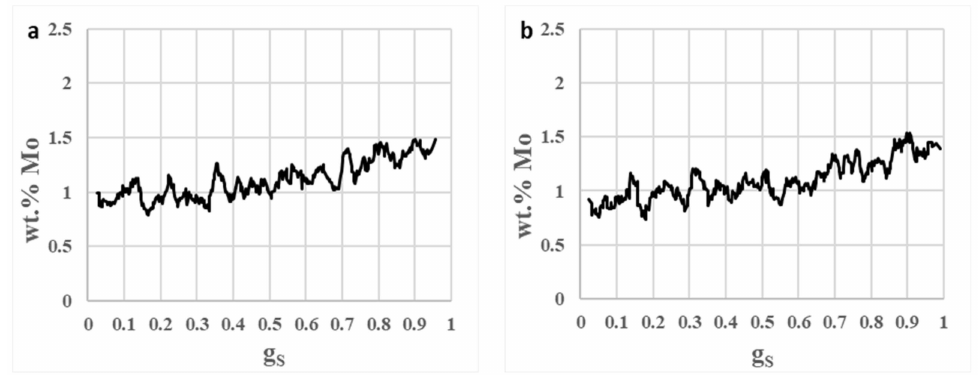
Figure 18. Measured Mo content in at ( a ) 15 mm and at ( b ) 60 mm from the surface.